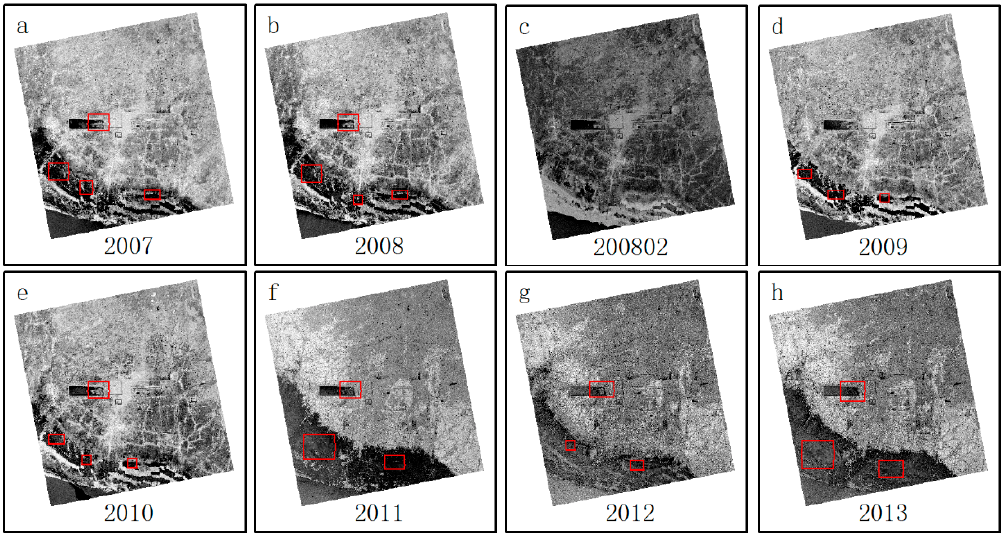
Figure 3. Pre-processed SAR images: ( a – e ) are PALSAR images; ( f – h ) are COSMO-SkyMed images. The portion of flood inundated areas are highlighted by red rectangle.